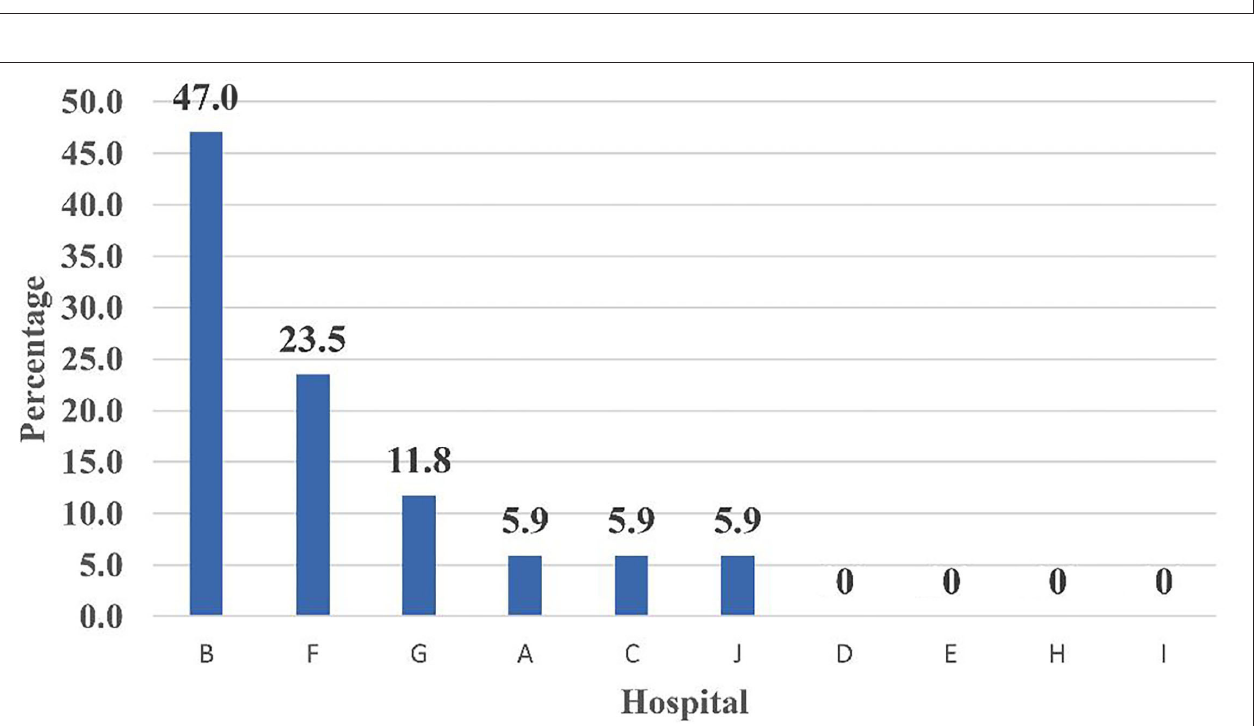
Frontiers in Public Health |